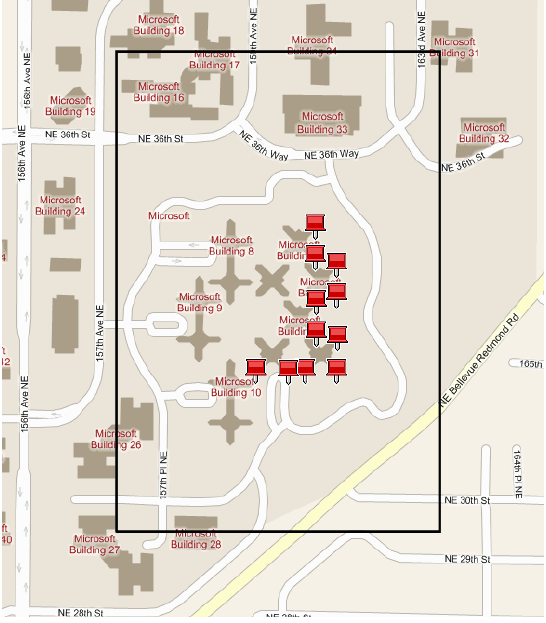
Figure 2. Experiment site settings.